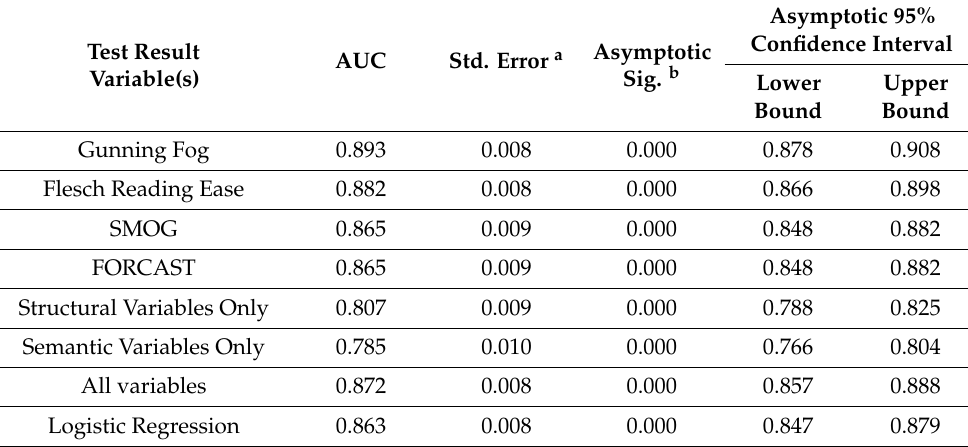
Table 5. Area under the receiver operator curve of readability formula and binary classifiers.